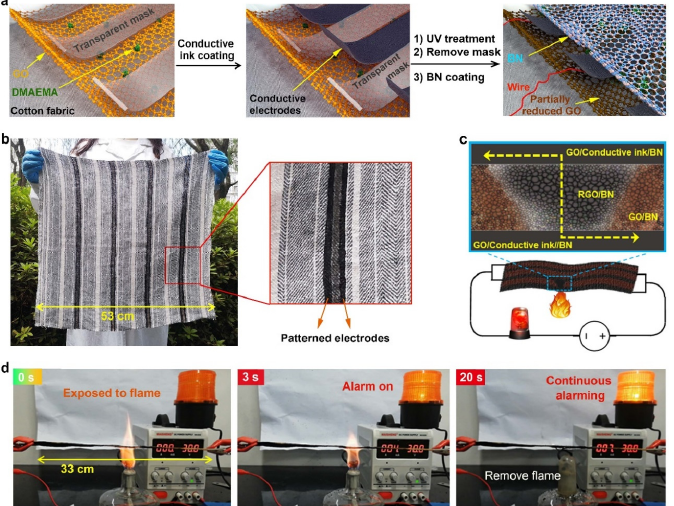
Figure 6. ( a ) Schematic illustration of the fabrication procedure of GO/PDMAEMA/BN and conduc- tive ink/BN patterned fabric. ( b ) Example of a large piece of striped fabric coated with conductive electrode and fire-sensing lines. ( c ) Construction of a large-area early warning sensor by connecting the conductive ink/BN lines in an interdigitated way. ( d ) A strip of 33 cm long patterned fabric was used for the demonstration of large-area sensing. (Adapted with permission from Ref. [44]. 2021, John Wiley and Sons).